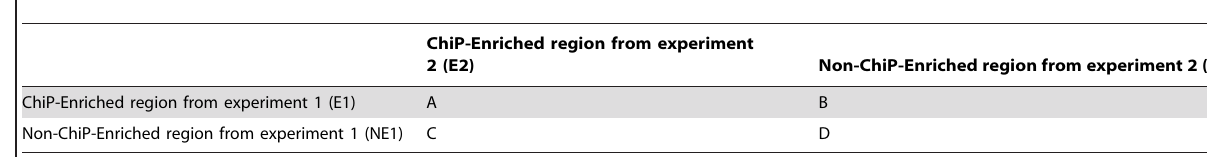
Table 3. Chi-squared contingency table